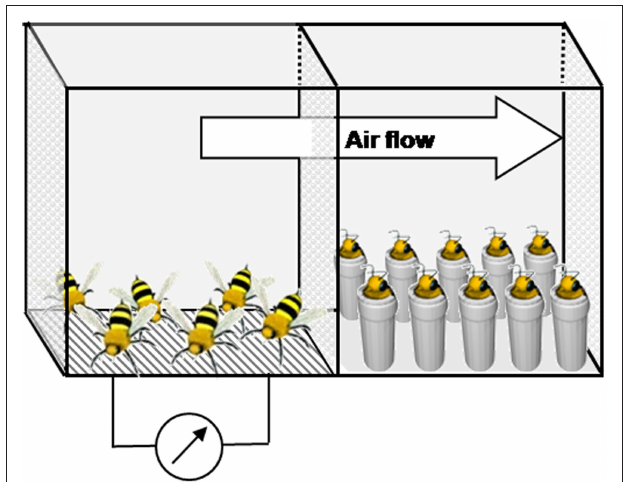
Figure 1 | experimental design for exposure to the natural blend of the sting alarm pheromone (SAP). Before conditioning, harnessed bees from the exposed group were placed in one compartment ( right ) for 30 min, in the presence of unrestrained bees receiving electric shocks (6–9.5 V) each time they landed on the electric grid placed in their compartment ( left ). The alarm pheromones emitted were directed toward the harnessed bees by an air flow created by an exhaustion system (indicated by the arrow; air flow ). For the sham group, no shock was applied to the